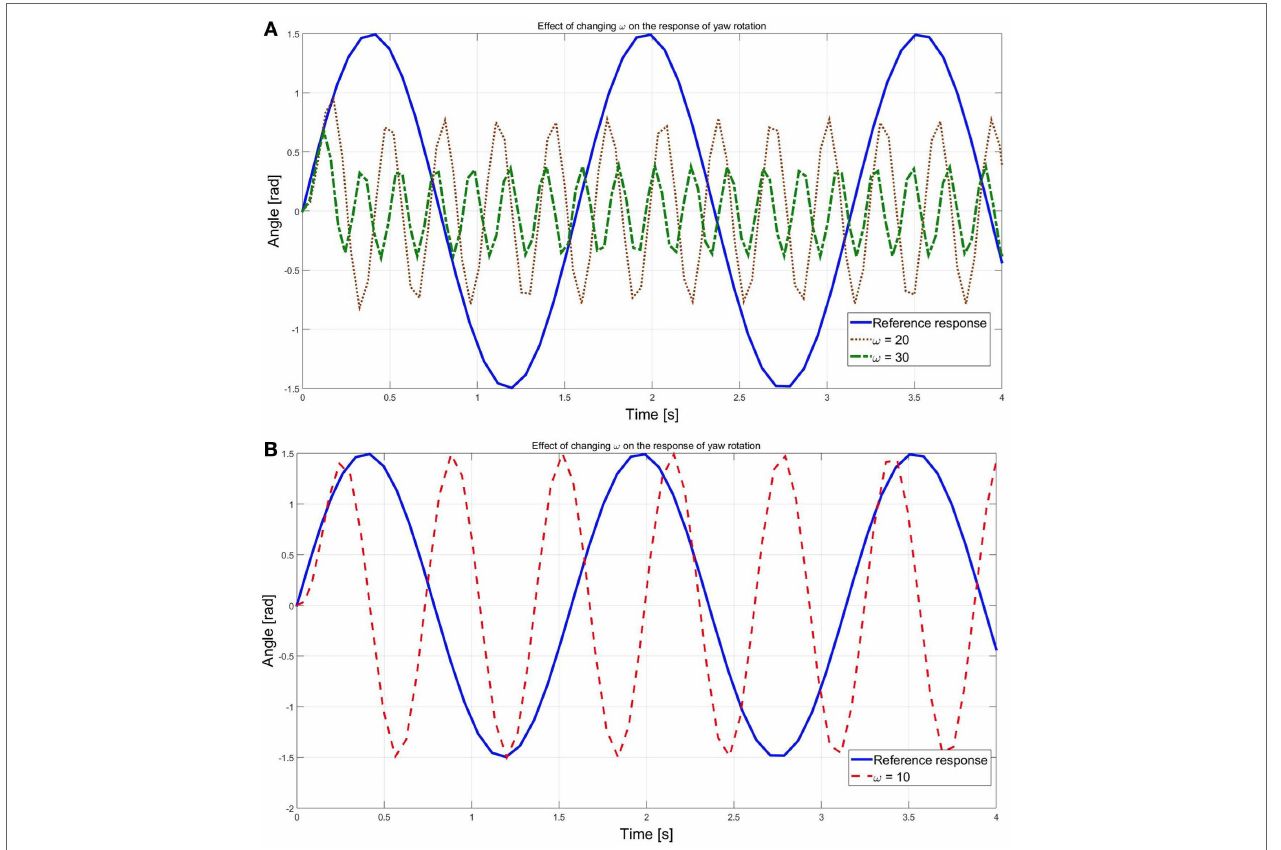
FIGURE 4 | Effect of input frequency on the neck yaw rotation response . (A) the output response for the undesired frequencies ( Ω p = 20 and Ω p = 30) (in green and in orange) is compared to the desired response (in blue). (B) the output response for the accepted frequency ( Ω p = 10)(in red) is compared to the desired response (in